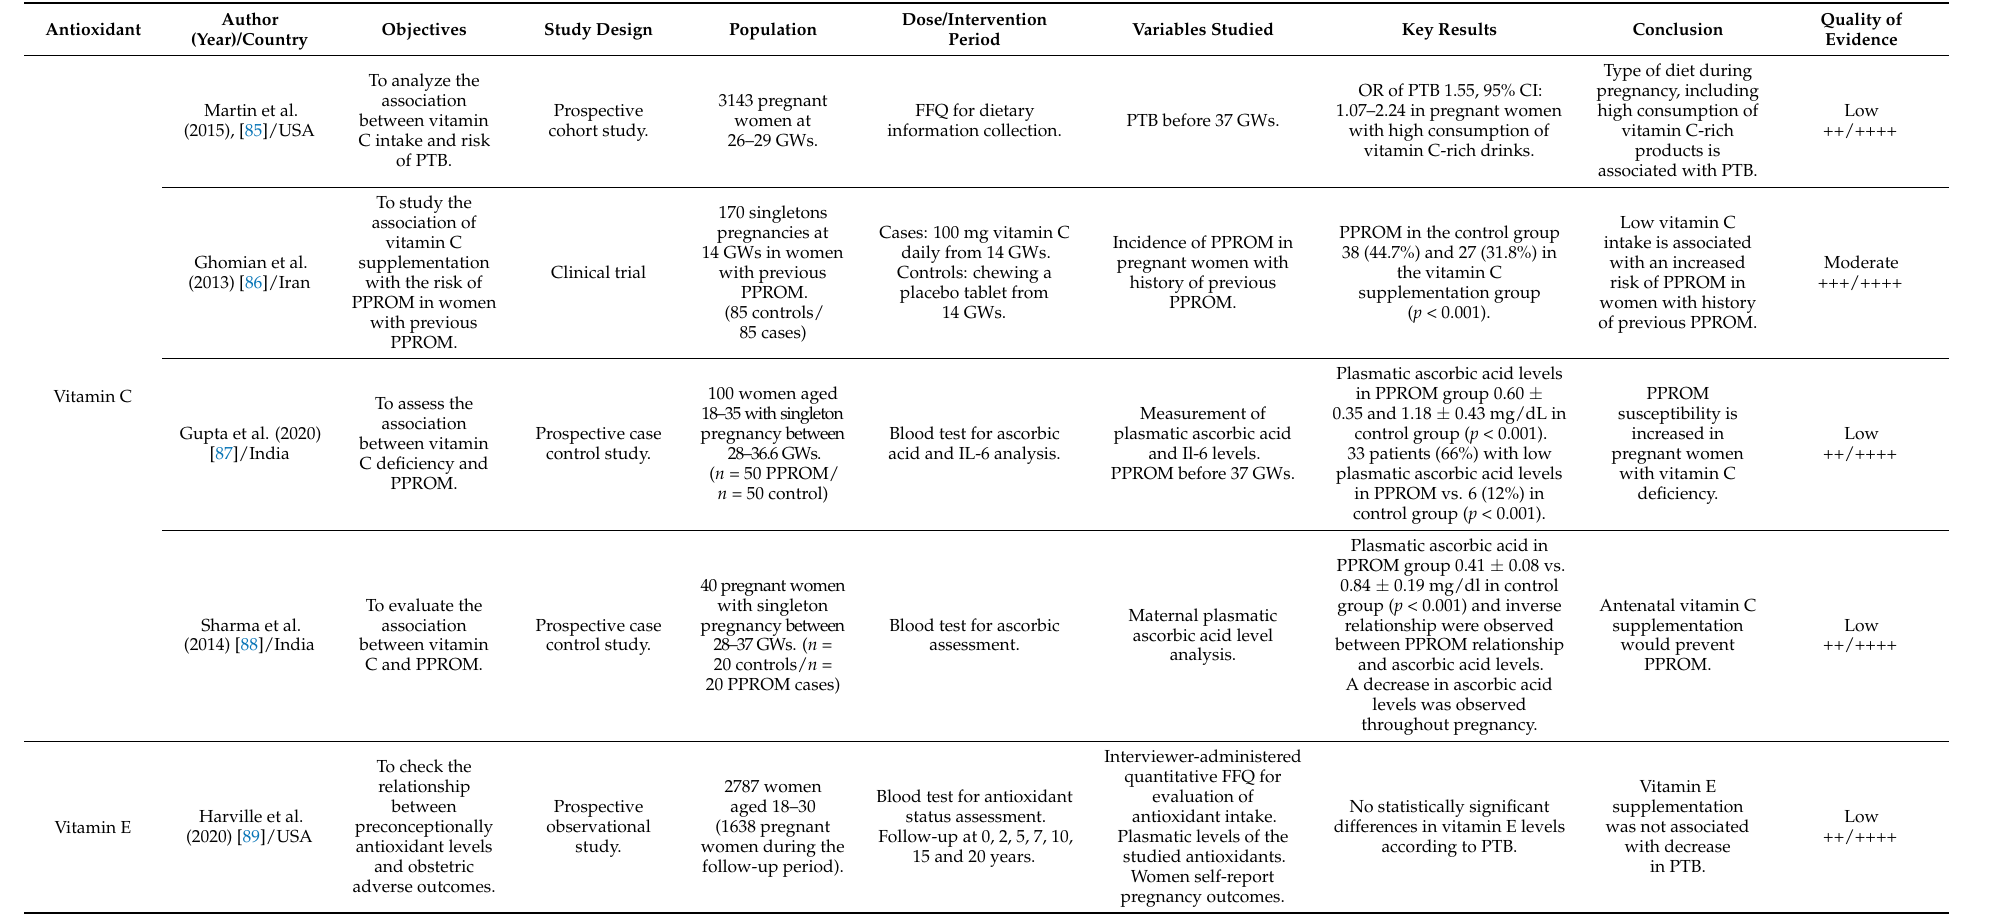
Table 2. Antioxidant use in the prevention of